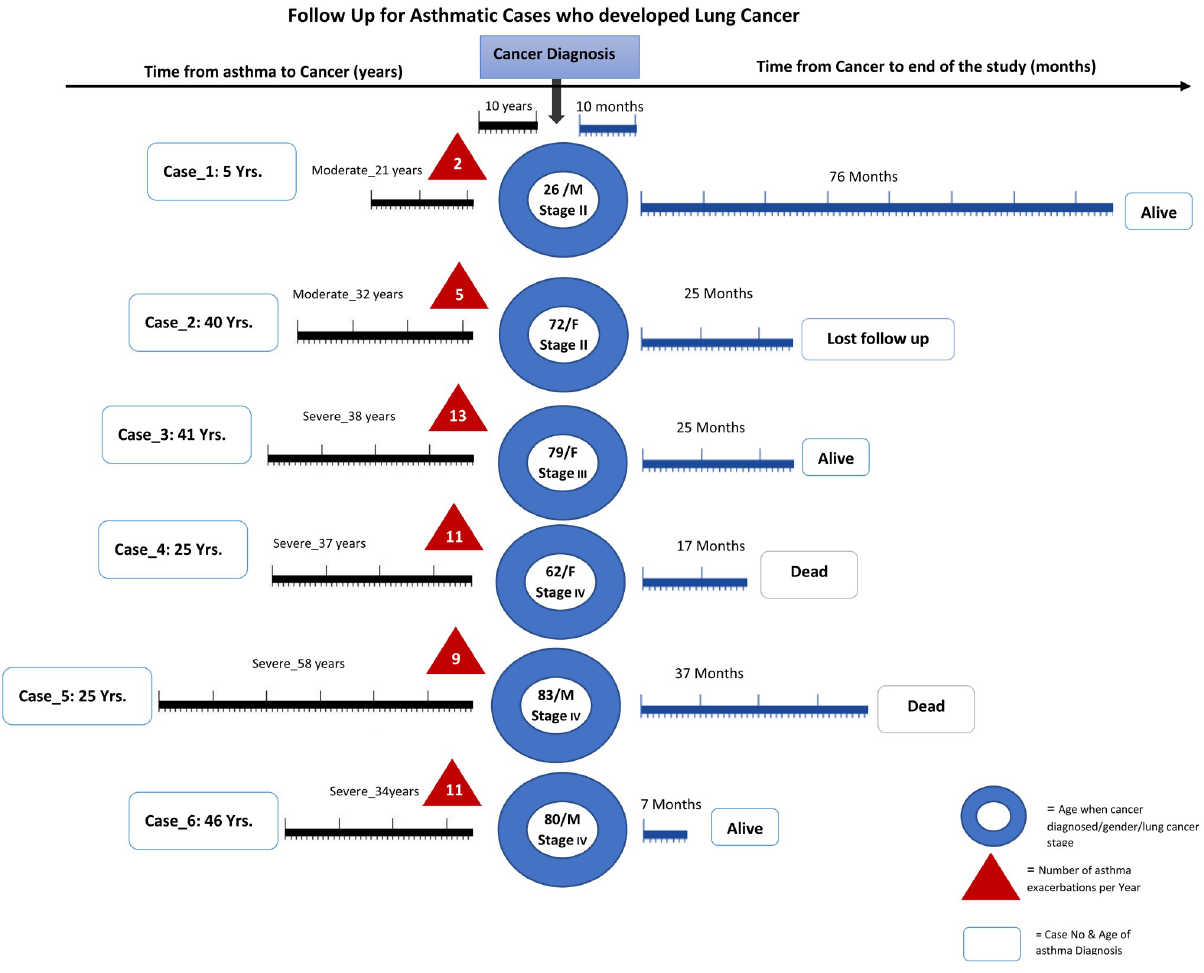
Fig 5. Follow-up for asthmatic cases who developed lung